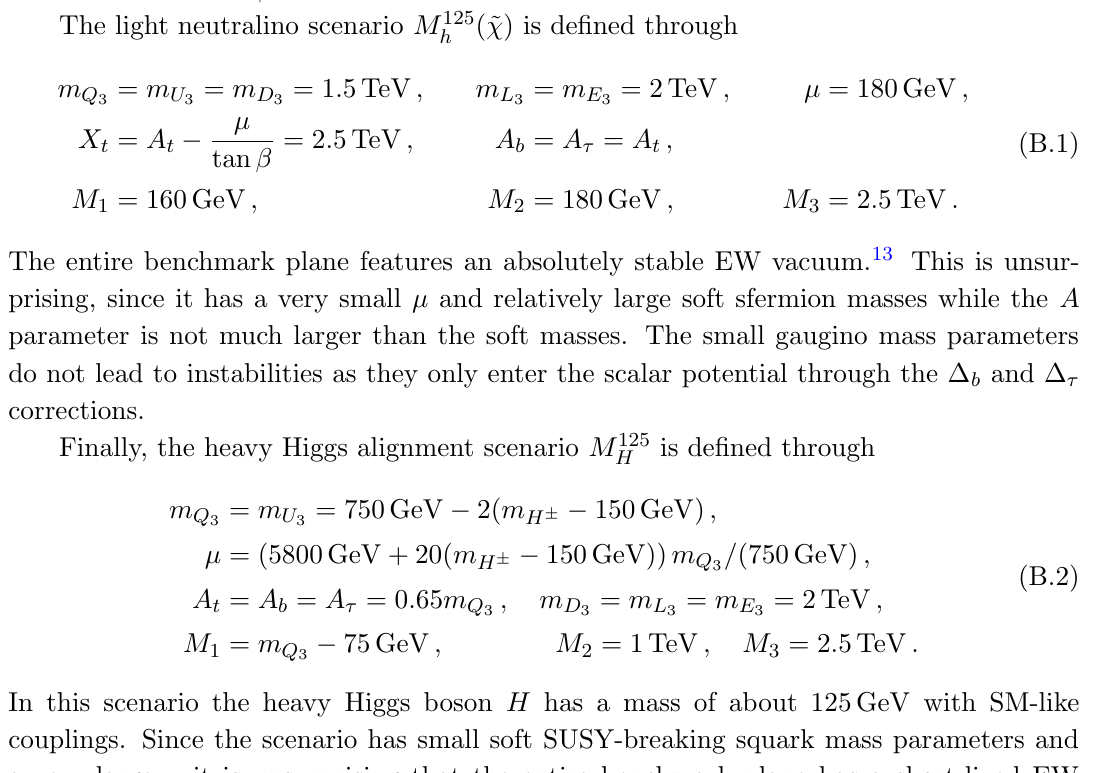
the parameter plane, while the global minimum has ~ b vevs for tan (cid:12) & 5 : 5 and ~ t -~ (cid:28) vevs for smaller values of tan (cid:12)